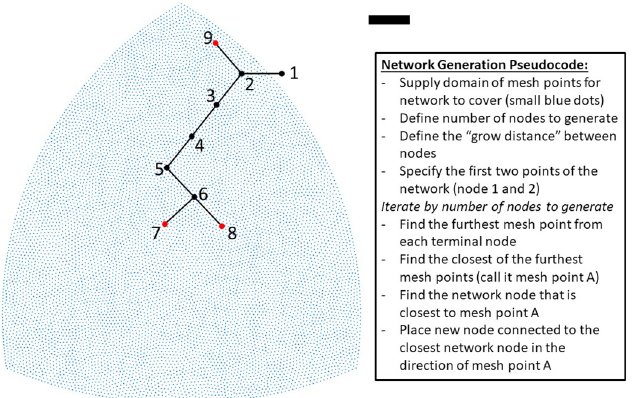
Fig 2. Example of angiogenesis-inspired network generation algorithm. Blue points define a mesh that the algorithm seeks to cover with a network. The black and red dots are the nodes generated by each iteration of the algorithm; red nodes denote network terminals; black lines are connections between nodes. The black scale bar is 1000 μ m. The first two nodes (1 and 2) are manually specified by the user. The algorithm determines the mesh points furthest from the network. For nodes 3-5, the southwest corner is the furthest mesh point. For node 6, the southeast corner is furthest and then for node 7 the southwest corner is furthest. For node 8, the southeast corner is the furthest point and is connected to closest node of the network—node 6. The northern most mesh point is furthest from both node 7 and 8. Node 9 is connected to node 2 since it is the closest node in the existing network. To implement the user needs to supply a domain of points to cover, the “grow distance” between nodes, and the number of nodes to